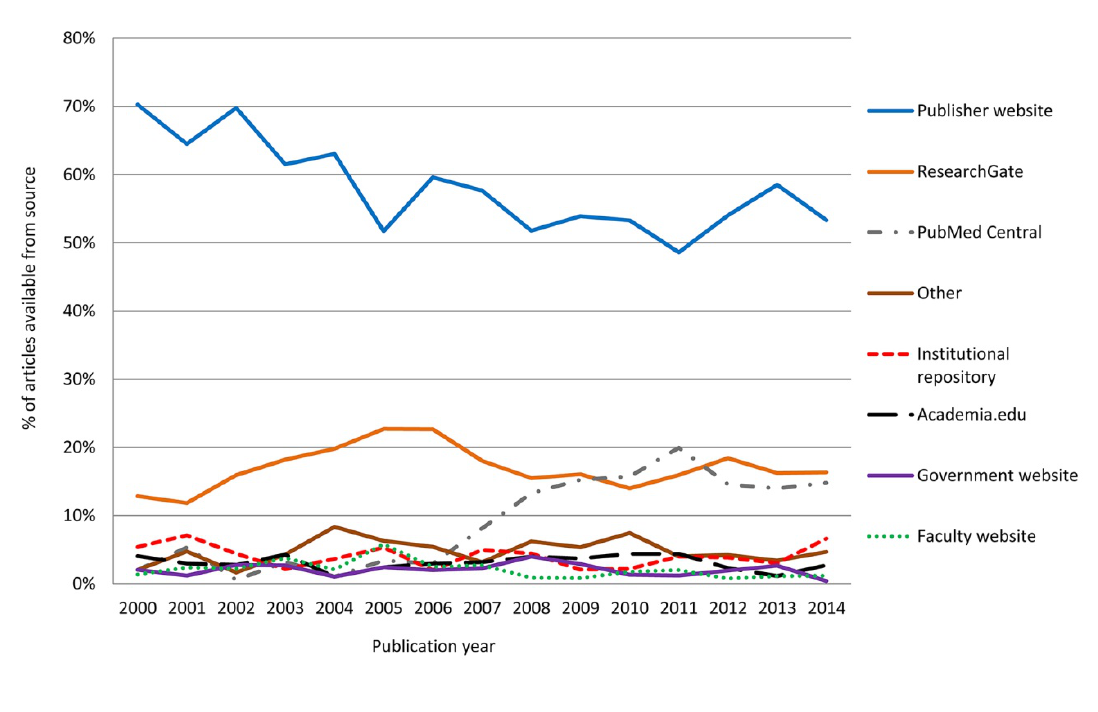
Figure 3 Sources of freely available articles over